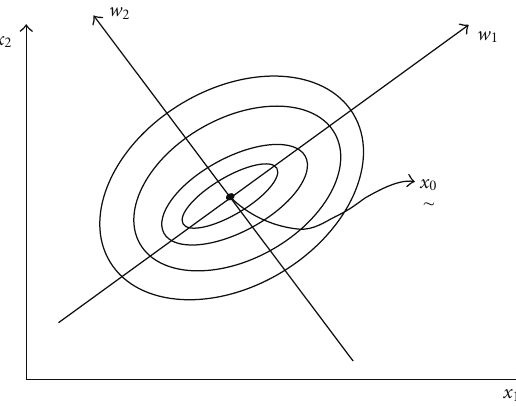
Figure 1: Graphical representation of axis translation. where (cid:4) y is the predicted response, x = independent variables vector, b = vector of the first order terms,